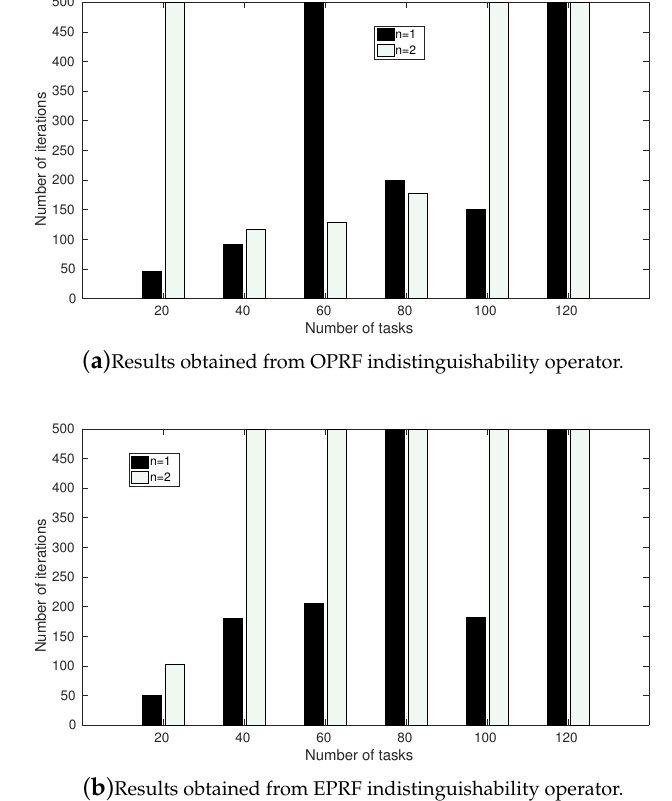
Figure 5. Number of iteration required to converge with probabilistic Markov chain with different values of n power ( n = 1,2), nTH = 2, several number of tasks and two clusters of tasks. 500 iterations means no